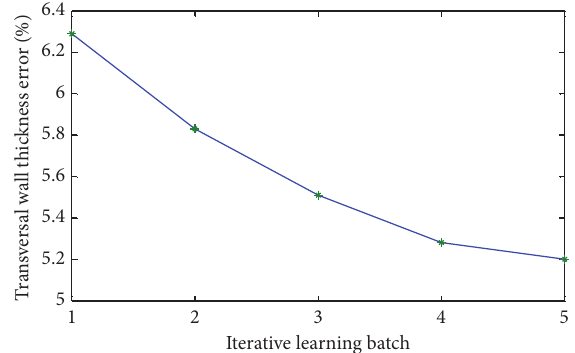
Figure 7: Iterative learning control effect of transverse wall thick- ness.